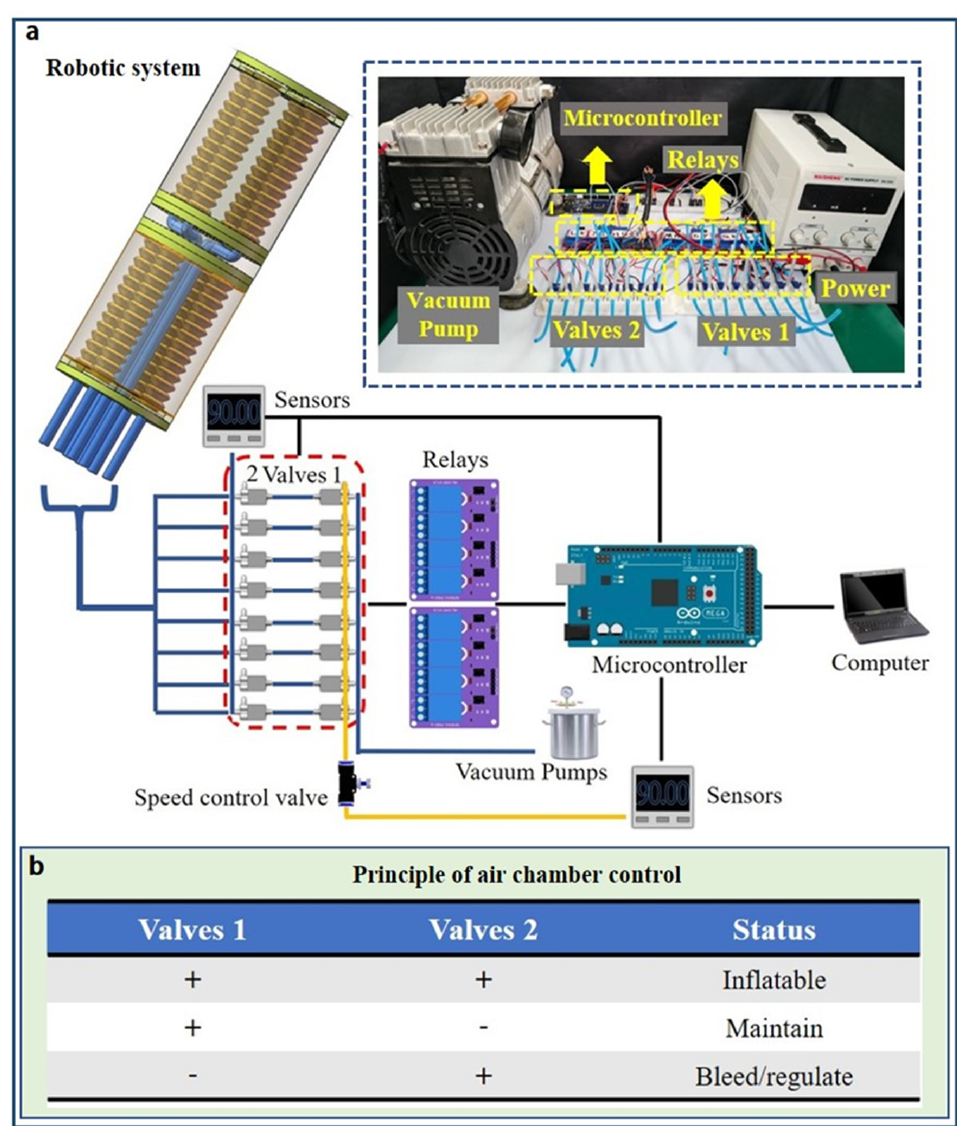
Figure 7. Robotic system: ( a ) configuration of the control system and ( b ) principle of air chamber control.